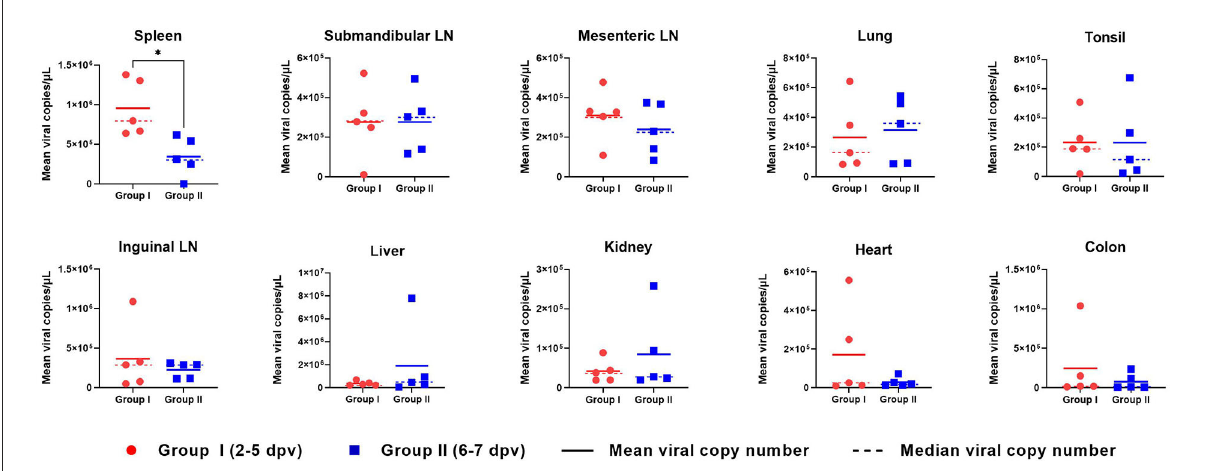
FIGURE5 Organ viral load in pigs experimentally infected with African swine fever virus. The mean (solid lines) and median (dotted lines) viral copy number per microliter in two groups divided by the number of days between the onset of viremia and death are shown. * p < 0.05. dpv, days post-viremia; LN, lymph